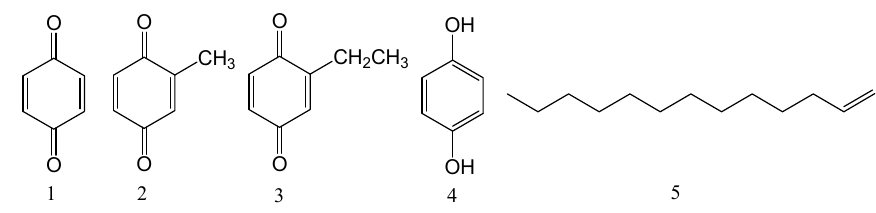
Figure 1. Structures of compounds 1 – 5 .